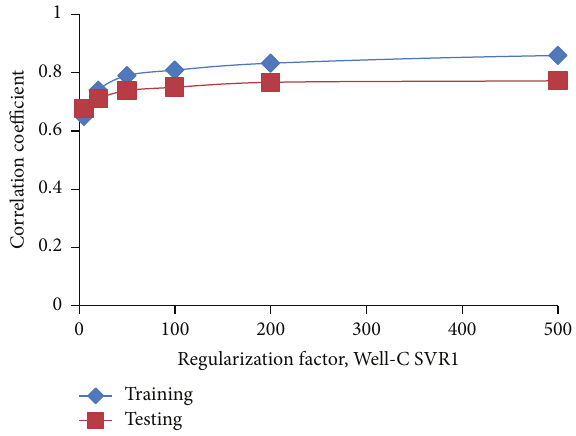
Training Figure 8: Sensitivity of SVR model to regularization factor (Well- C).